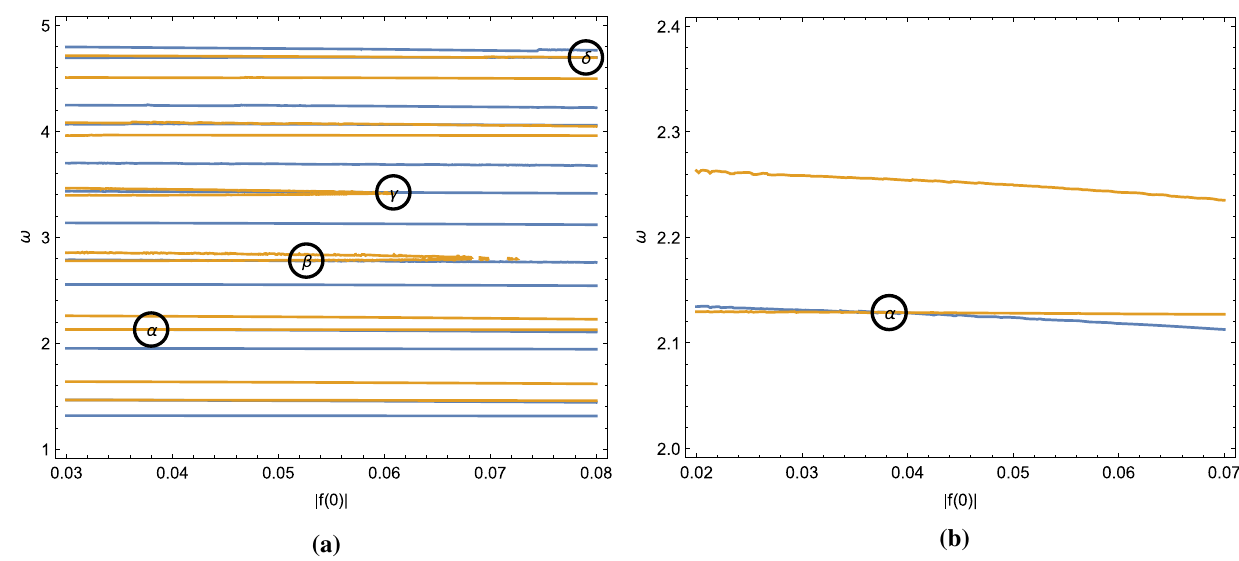
Fig. 2 a Curves of vanishing real and imaginary parts of G (ω, | f ( 0 ) | ) in the d = 6 elliptic case. Four solutions were found in order of increasing ω and | f ( 0 ) | . b The curves of vanishing real and imaginary parts of G (ω, | f ( 0 ) | ) in the d = 6 elliptic case for α branch